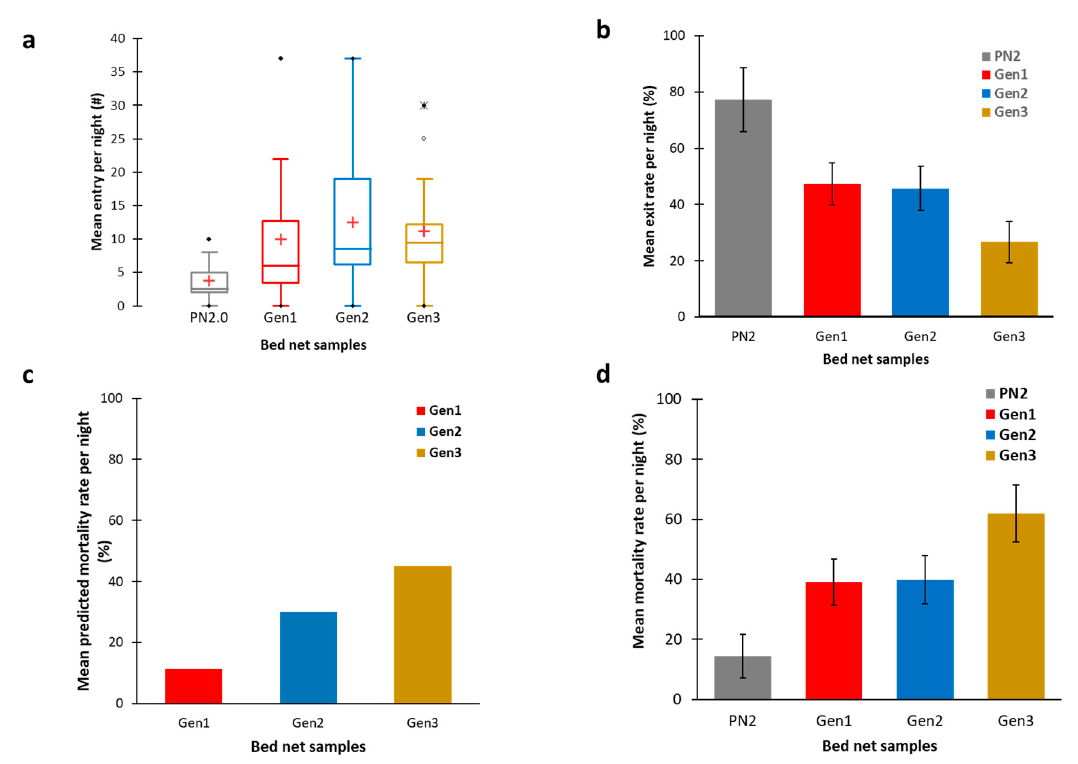
Figure 3. Performance of Gen1, Gen2, and Gen3 insecticide-free T-Nets in comparison to the Permanet 2.0 LLIN (PN2.0) in Tiassale (Cote d’Ivoire) where mosquitoes are resistant to insecticides. The nets were randomly allocated to four huts. Nets and sleepers were rotated each night. Up to 14 observations were made. ( a ) The mean number of mosquitoes entering each hut per night, ( b ) the mean exit rate per hut per night, ( c ) the mean predicted killing rate of the T-Net, and ( d ) the mean mortality rate per hut per night (trapped = dead and ecologically-dead mosquitoes). The bars on top of the histograms represent the 95% confidence intervals.